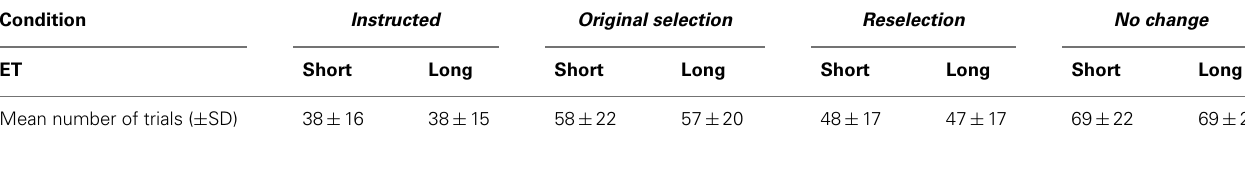
Table 1 | Final mean ( ± SD) number of trials per condition after rejecting incorrect and anticipatory trials.